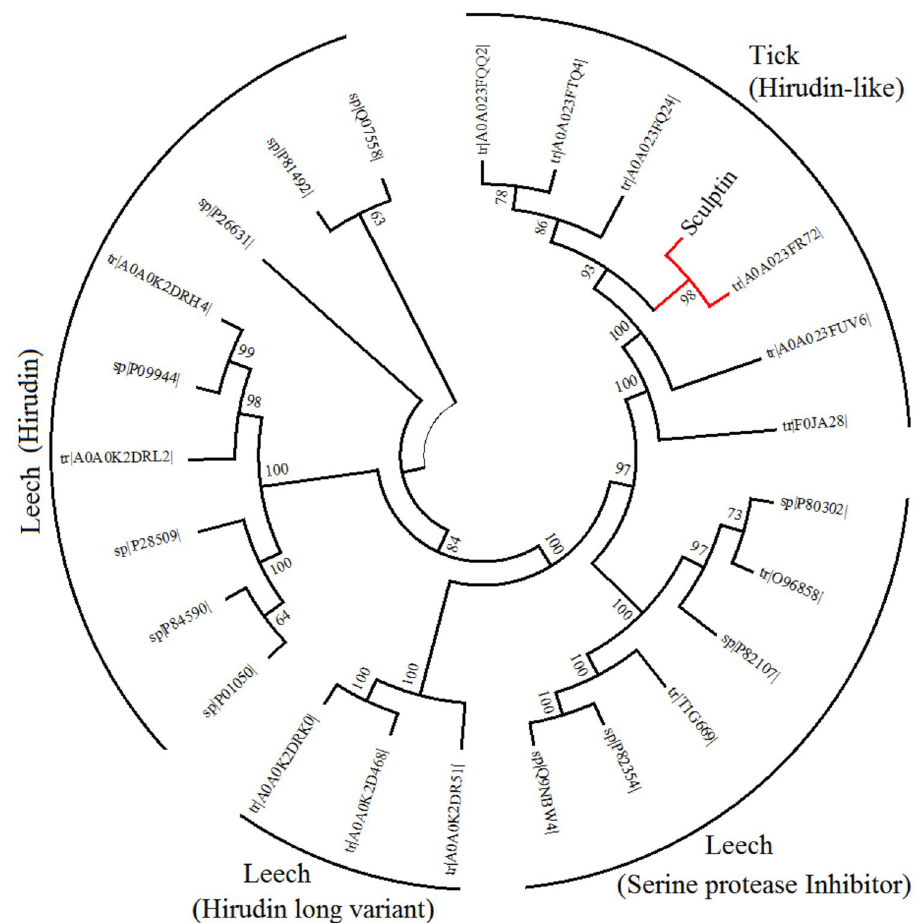
Figure 1. Phylogenetic analysis of Sculptin. Protein sequences of thrombin inhibitors from ticks and leeches were retrieved from Swiss-Prot/TrEMBL database (www.uniprot.org) and the phylogenetic profile was inferred using the Neighbor-Joining method using MEGA 7.0. The bootstrap consensus were 100 and cut-off value for condensed tree was 60% collapsed bootstrap replicates (see, experimental procedures). The accession number of each sequence is given and query position is highlighted in red. A single domain of sculptin was taken in to account during phylogeny